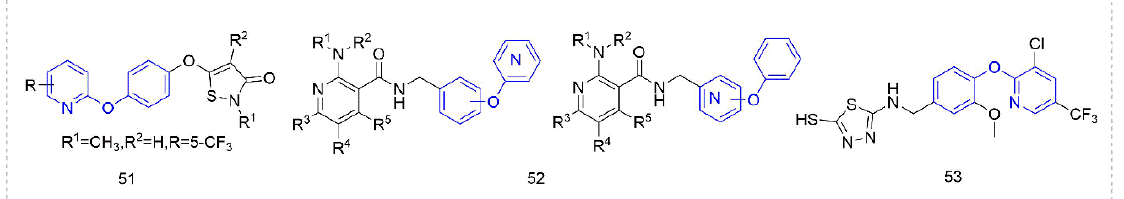
Figure 9. Succinate dehydrogenase inhibitors containing phenoxypyridine.